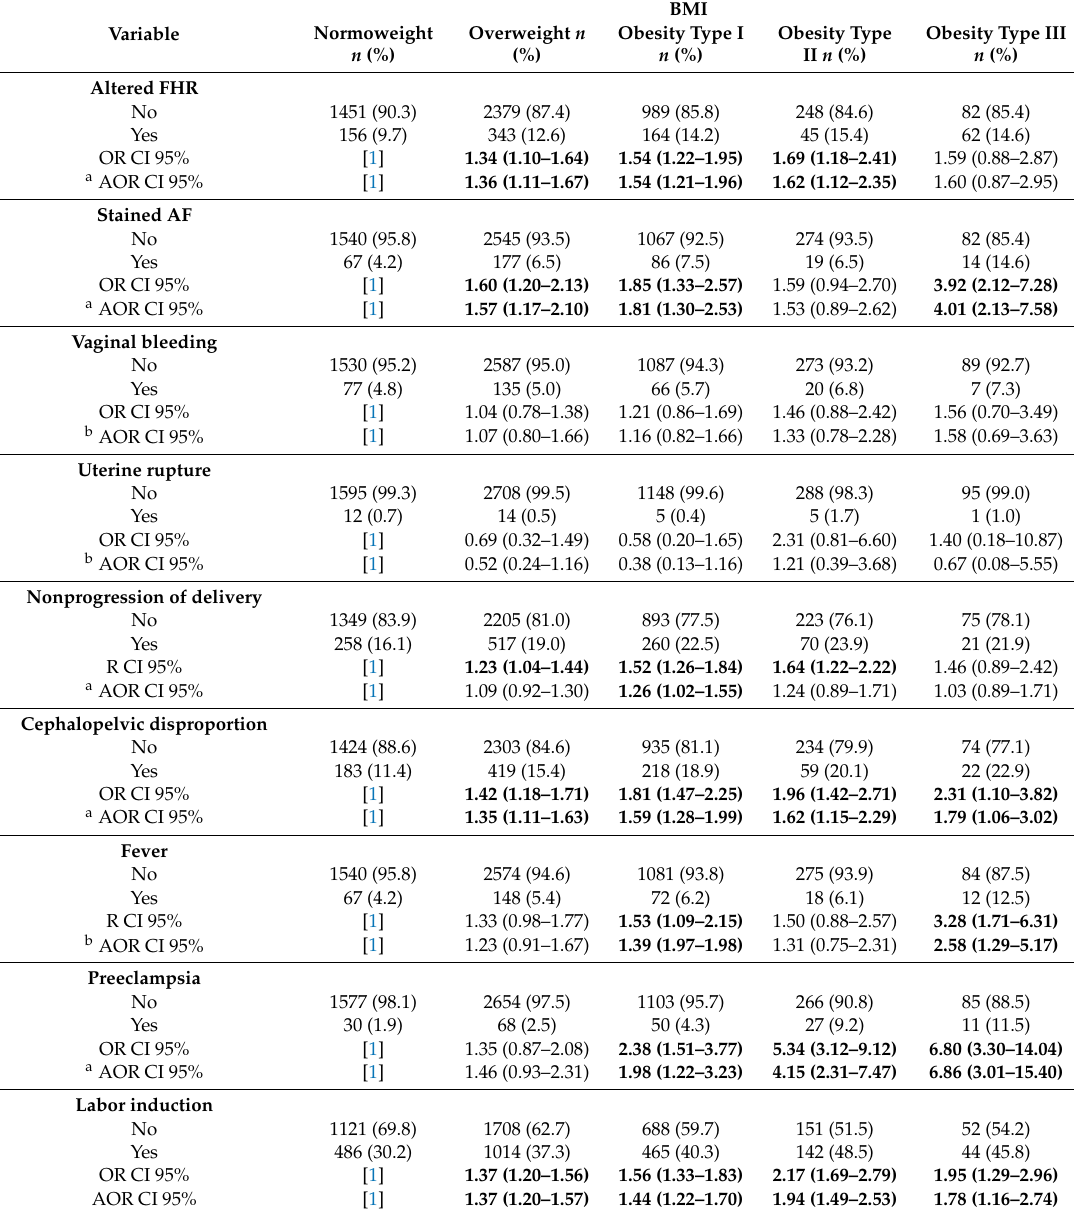
Table 3. Complications during delivery according to the